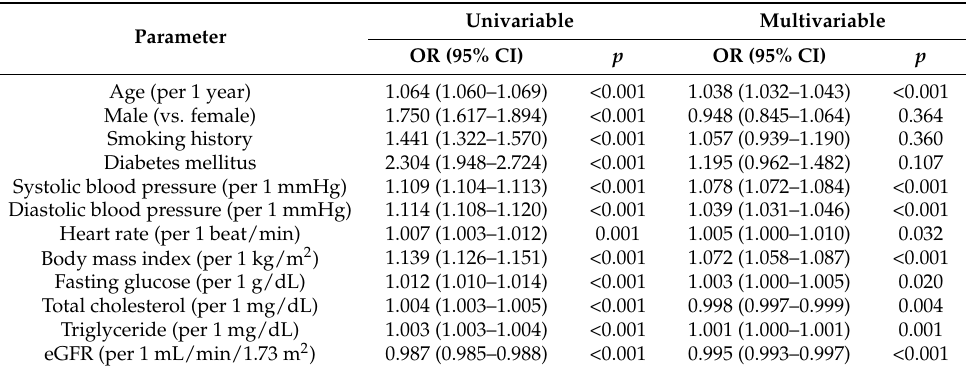
Table 4. Determinants of new-onset hypertension using binary logistic analysis in the traditional definition population (hypertension was defined as systolic blood pressure ≥ 140 mmHg or diastolic blood pressure ≥ 90